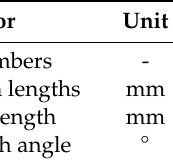
Table 6. The orthogonal arrays of U ∗